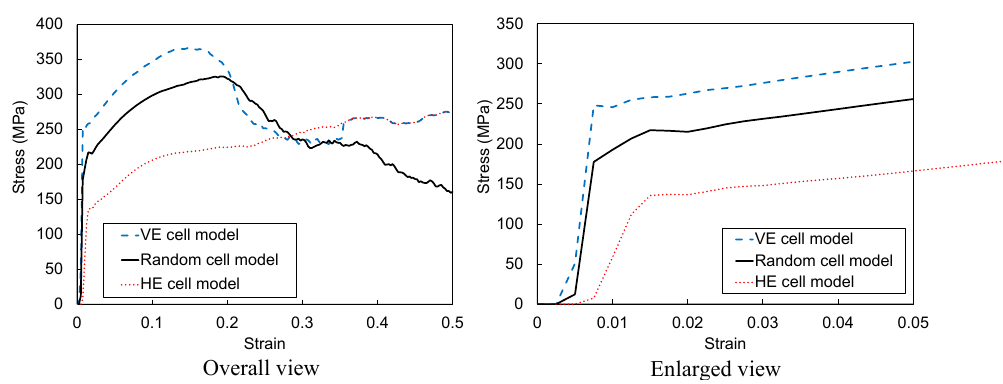
Fig.6. Stress–strain relationships of random, VE, and HE cell models.